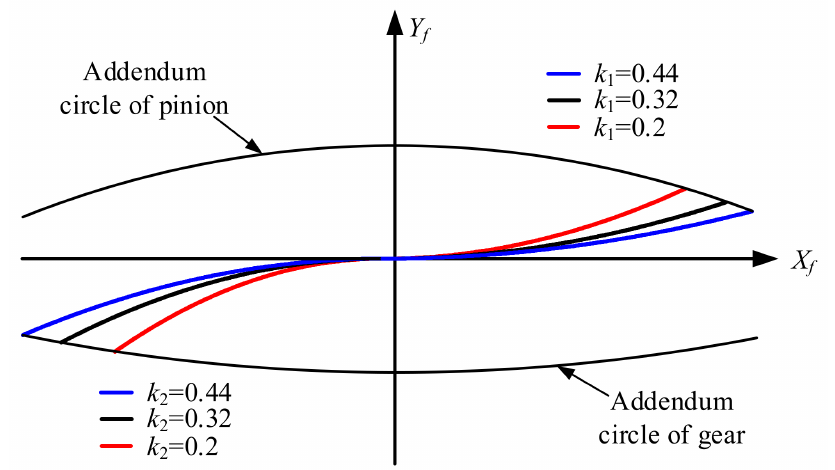
Figure 9. Designation of the parabolic path of contact of the novel